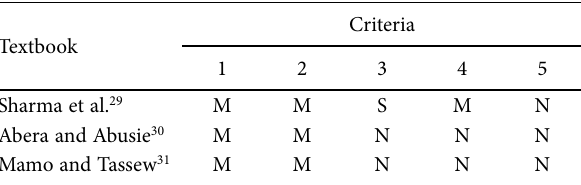
Table 2. Results of analysis of Ethiopian secondary school